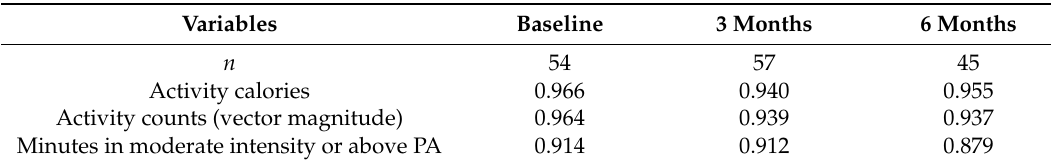
Table 4. Intraclass correlations (ICC) calculated at three time points